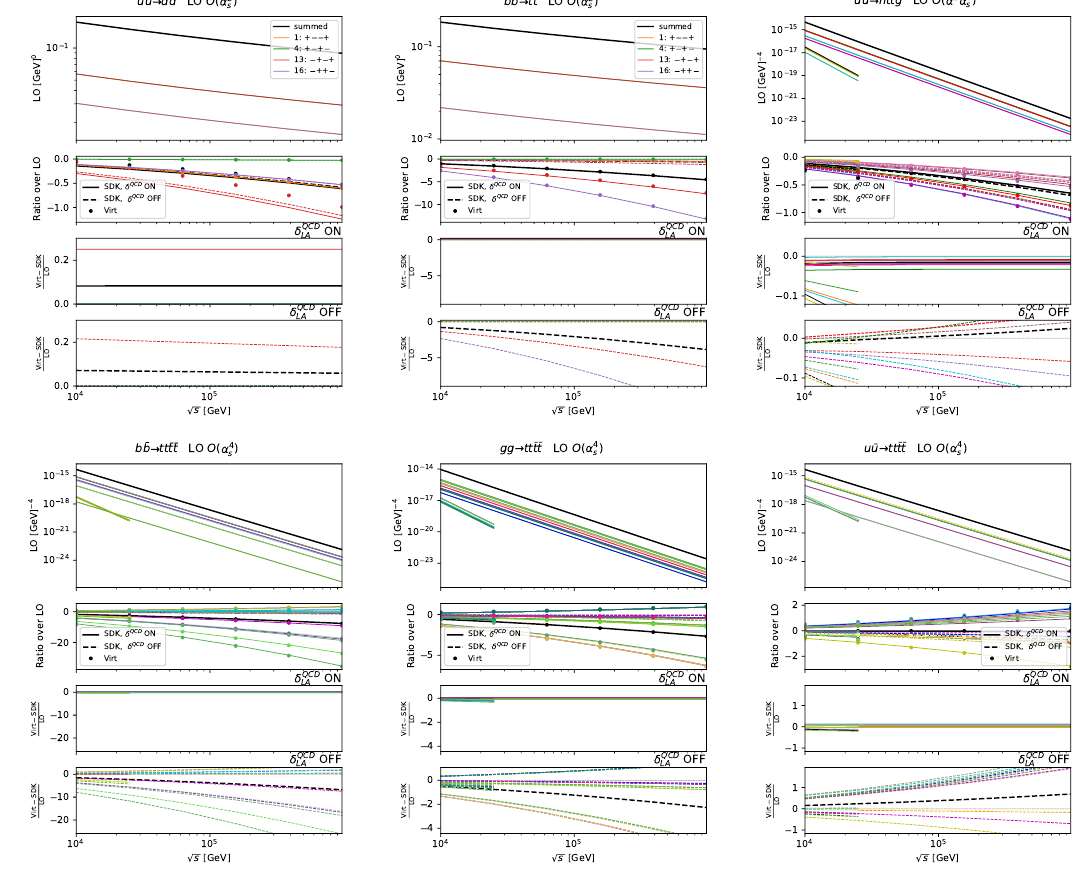
Figure 4 . Comparison between exact results (dots) for O ( (cid:11) ) NLO EW virtual corrections and their LA (lines) in the case of squared matrix elements of representative 2 ! n processes with n = 2 ; 3 ; 4 . Solid lines include the (cid:14) QCD contribution, while dashed lines do not. Plots show a scan in energy for LA fixed r kl =s ratios. More details are given in the